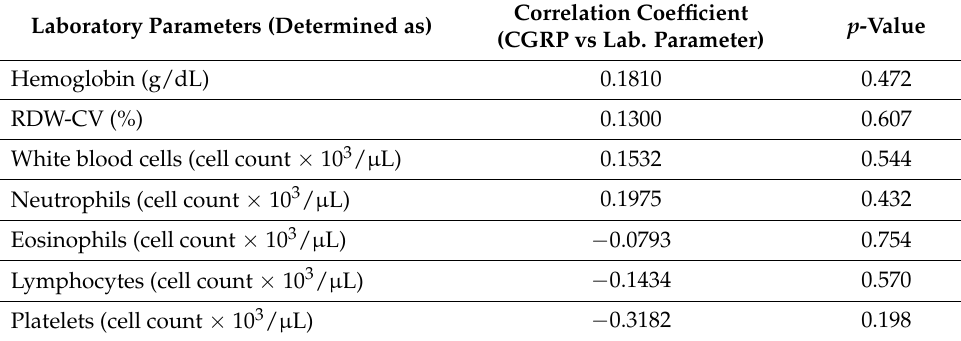
Table 9. Multiple correlation analyses between baseline (t0) plasma CGRP levels (ng/mL) and laboratory parameters. Bold text highlights the statistically significant